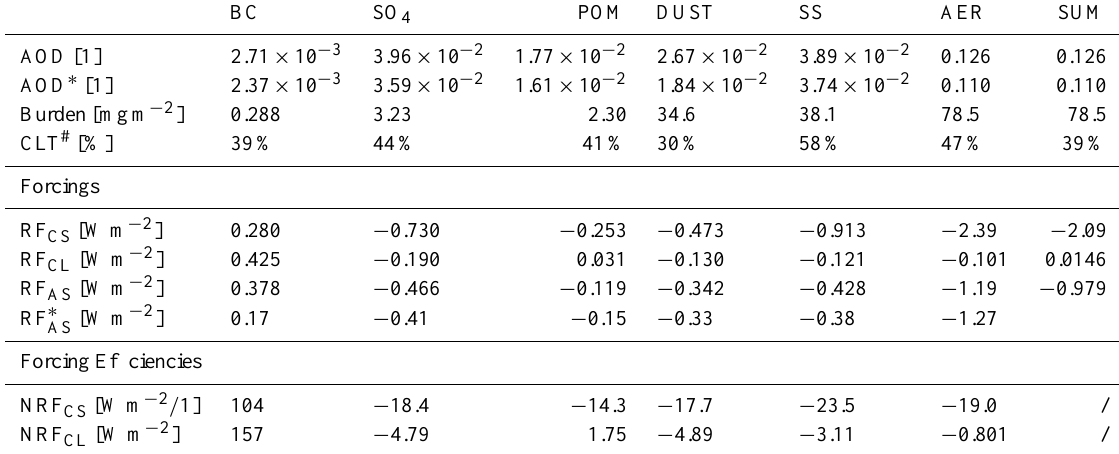
Table 2. Characteristic properties of the reference simulation using the default configuration of LMDz with the full aerosol distribution, (above, inside, below clouds, including the area with completely clear columns). “BC” stands for black carbon, “SO 4 ” for sulfate, “POM” for particulate organic matter, “DUST” for mineral dust, “SS” for sea salt, “AER” for forcing diagnostics established using instantaneous, total aerosol optical properties, and “SUM” for arithmetic sum of values from individual aerosol species diagnostics. AOD stands for all-sky aerosol optical depth at 550nm wavelength; AOD ∗ , the average optical depth when excluding completely clear columns; CLT # , effective cloud fraction (see text); RF, direct radiative forcing against an aerosol-free atmosphere; NRF, RF normalized to AOD; “CS”, clear sky; = ( 1 − CLT ) · RF “CL”, cloudy sky only; and “AS”, all sky. Cloud mask hypothesis derived all-sky forcings RF ∗ CS . AS BC SO 4 POM DUST